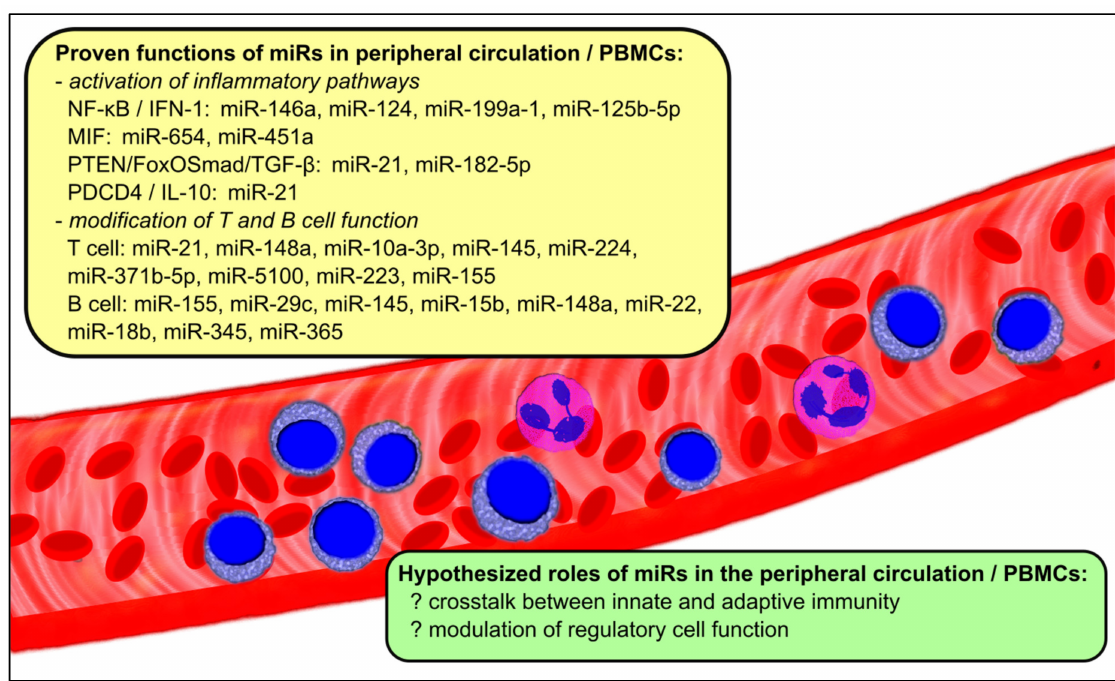
Figure 1. The roles of miRs in the peripheral circulation and PBMCs in